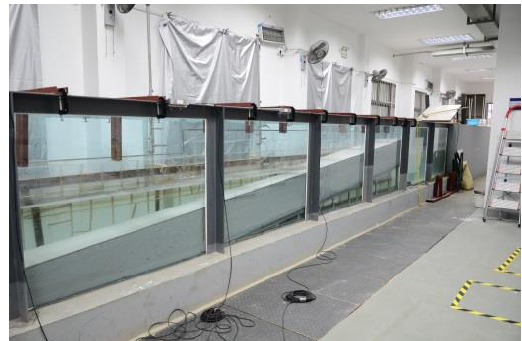
Figure 1. Wave flume and beach model.